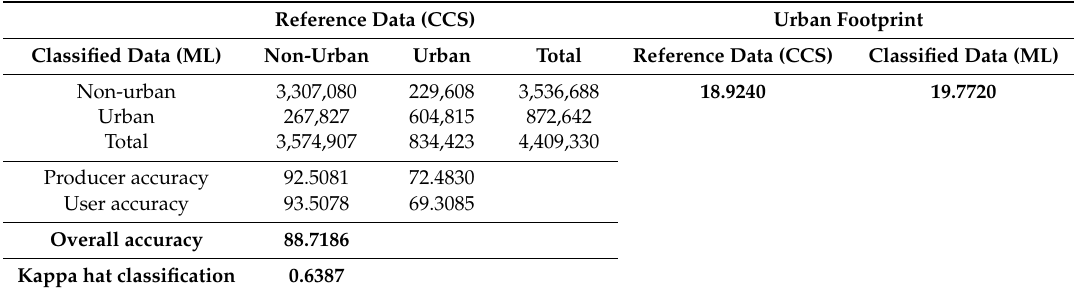
Figure 12. ( a ) The test area of Verona as seen from a Sentinel-2B image from March 2019 (see Table 2), displaying the ROIs digitized as training inputs for machine learning algorithms. ( b ) Supervised classification (using ML classifier) run over the series of interferometric coherence images previously considered. ( c ) Accuracy assessments using CCS as a reference map. The scale indicated in ( a ) is equivalent in all three images, therefore we did not replicate it for a better visibility of the result images. Results from accuracy assessments (Figure 12c and Table 8) display the same high accuracy values previously obtained in other test areas, with overall accuracy close to ≈ 90%, kappa coe ffi cient > 60%, and a percentage error from the CCS lower than ≈ 1% in terms of urban footprint. Table 8. Error matrix related to ML classification performed on the target area of Verona (Figure